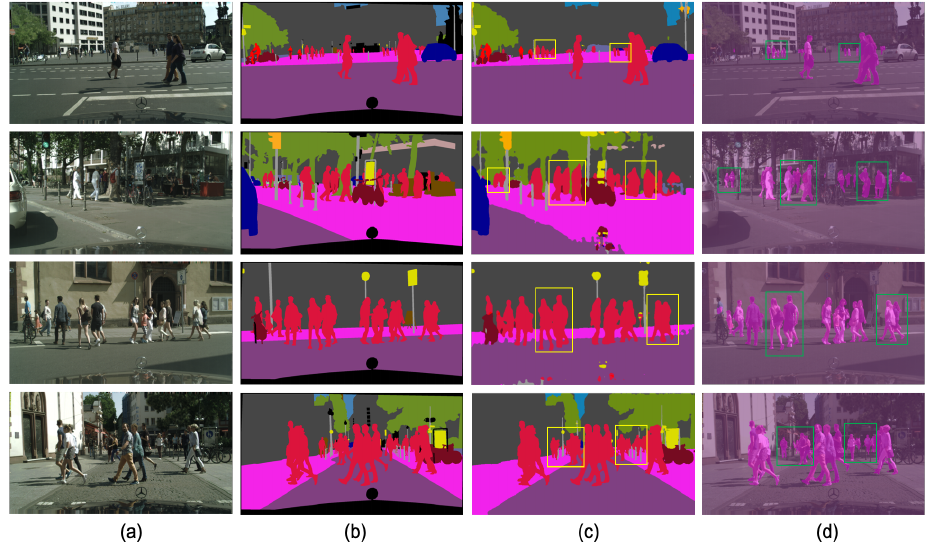
Figure 3. Visual results from the Cityscapes Validation set [12], from which a comparison between the predictions can be observed, made by the model LBN-AA DASPP [17]: First column ( a )—Original image; second column ( b )—Groundtruth; third column ( c )—LBN-AA DASPP Results; fourth column ( d )—Results obtained with the FASSD NeT model.